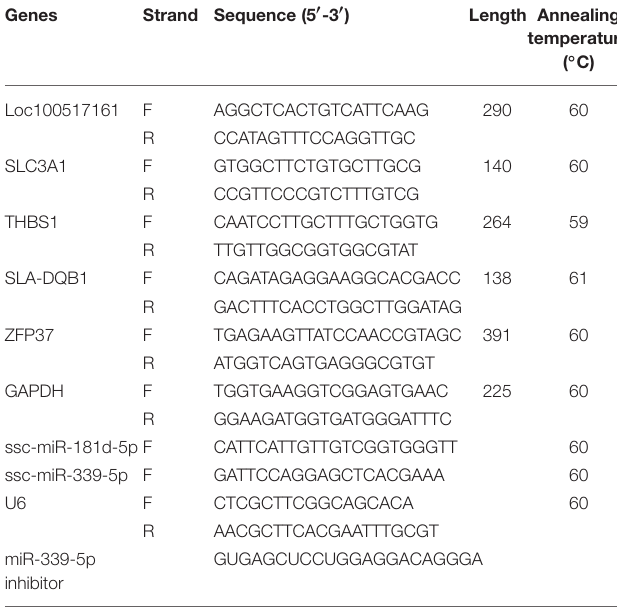
TABLE 1 | Primers used in this